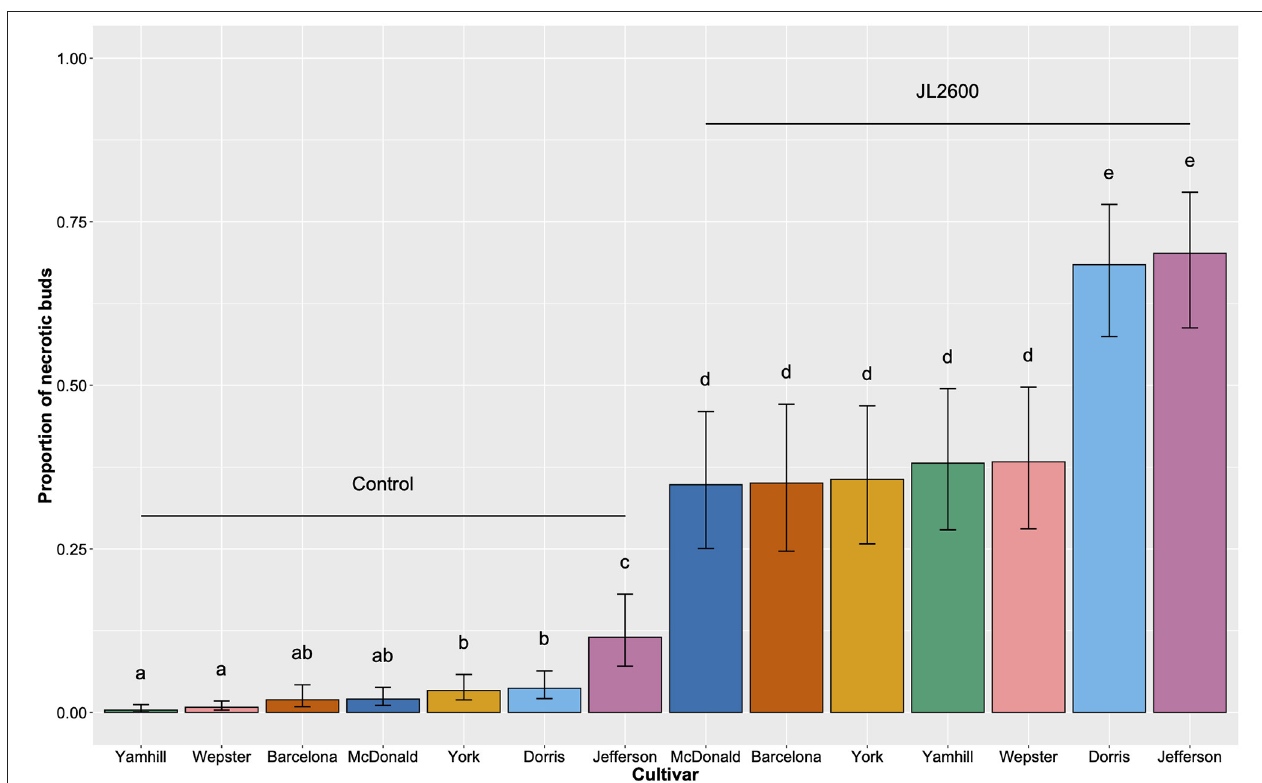
FIGURE 5 | Comparison of the proportion of necrotic buds across seven different cultivars of hazelnut consisting of 880 potted trees ( in vivo ) maintained outdoors. Each tree had between 7 and 20 buds inoculated by injection in fall 2018 with sterile phosphate buffer (Control), or the bacterial blight pathogen Xanthomonas arboricola pv. corylina strain JL2600. The population was evaluated in spring 2019. Vertical bars represent 95% CI. Different letters above bars indicate significant differences by Tukey’s HSD ( p <